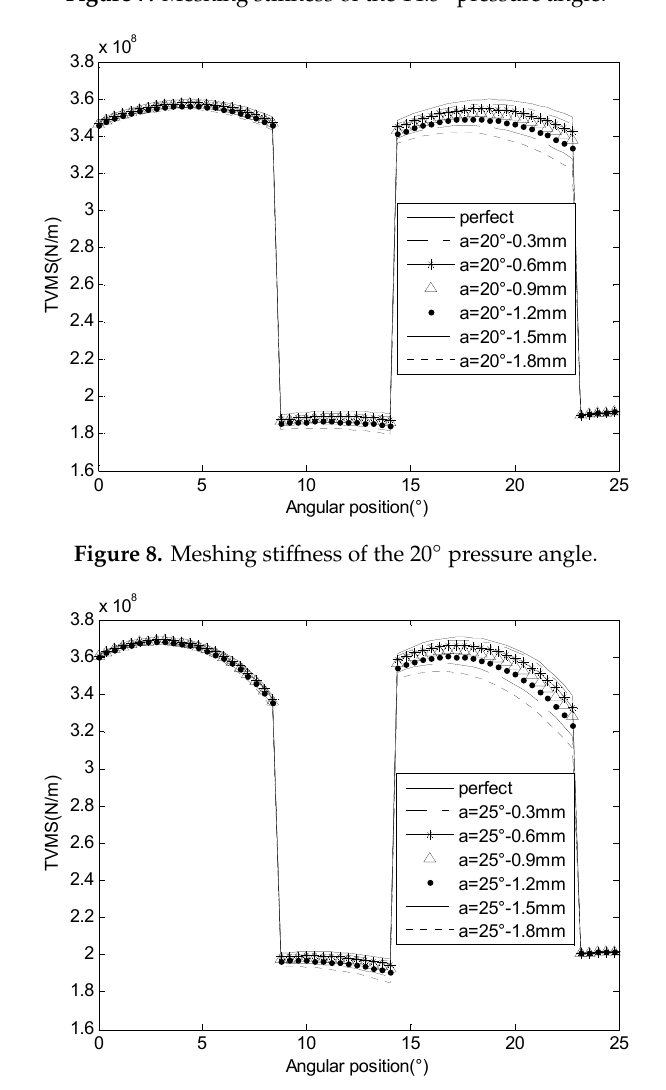
ff ness of the 25 ◦ pressure Figure 9. Meshing stiffness of the 25° pressure angle. Figure 9. Meshing sti